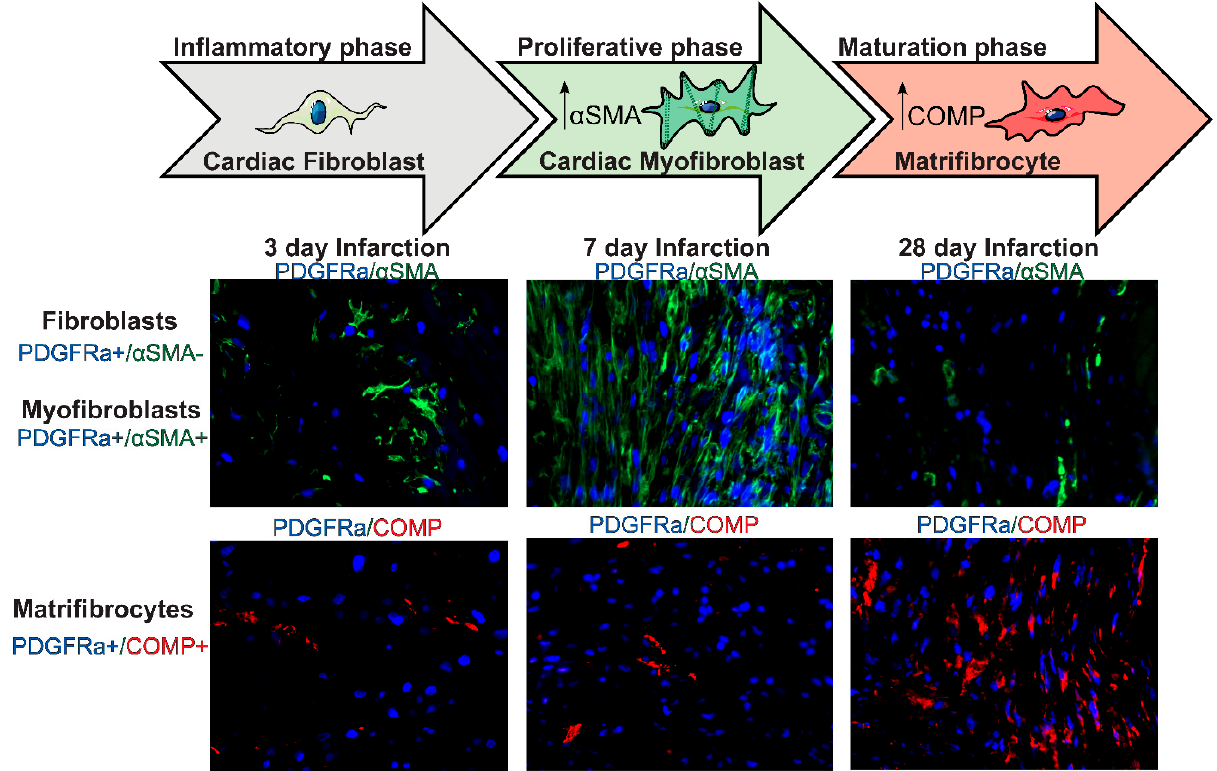
Figure 3. Dynamics of fibroblast activation during the proliferative and maturation phases of infarct healing. During the inflammatory phase of infarct healing, resident cardiac fibroblasts (identified as PDGFR α + cells in PDGFR α EGFP reporter mice) do not express the myofibroblast marker a-smooth muscle actin ( α -SMA). During the proliferative phase (3–14 days), many fibroblasts become activated, proliferate, and differentiate into cardiac myofibroblasts (PDGFR α +/ α -SMA+) that secrete large amounts of extracellular matrix proteins. During the maturation phase of infarct healing (14 days-2 months), myofibroblasts disassemble the α -SMA+ stress fibers and convert to matrifibrocytes, specialized cells expressing bone-cartilage proteins, such as cartilage oligomeric matrix protein (COMP).